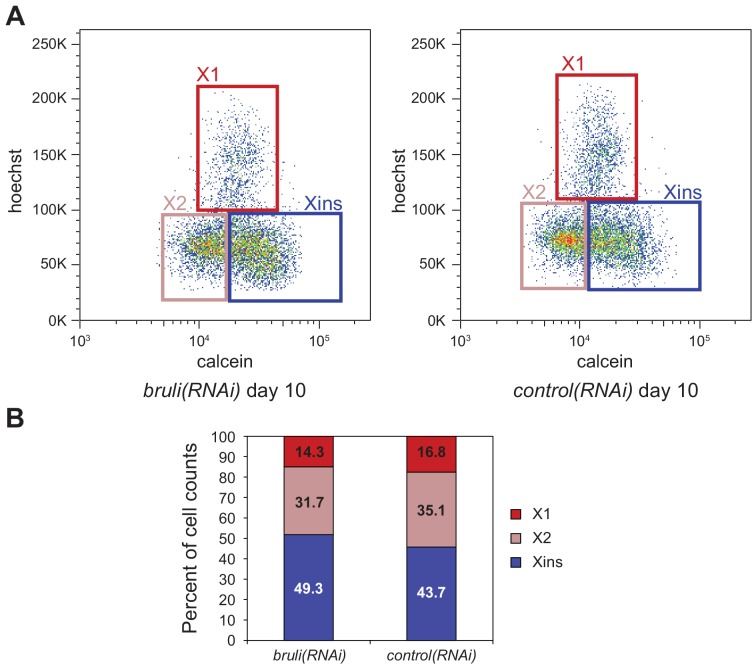
Identification of bruli and mbnl as major regulators of neoblast-specific AS.(A) FACS scatter plots for bruli and control RNAi treated animals 10 days after RNAi inyection. (B) Proportion of cells in X1, X2 and Xins fractions 10 days after bruli and control RNAi treatment.